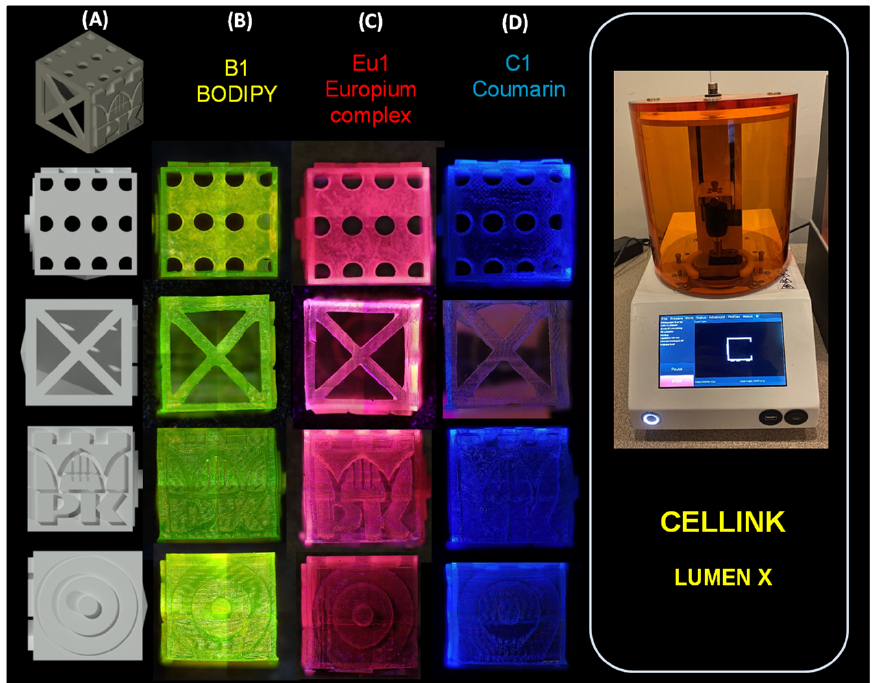
Figure 6. ( A ) Three-dimensional cube model made in AutoCAD 2020; print comparison obtained by LumenX printer. Comparison was made with light on (366 nm) for: ( B ) BODIPY; ( C ) Eu1; and ( D ) Coumarin 1. Three-dimensional objects were observed using the OLYMPUS DSX1000 optical microscope.